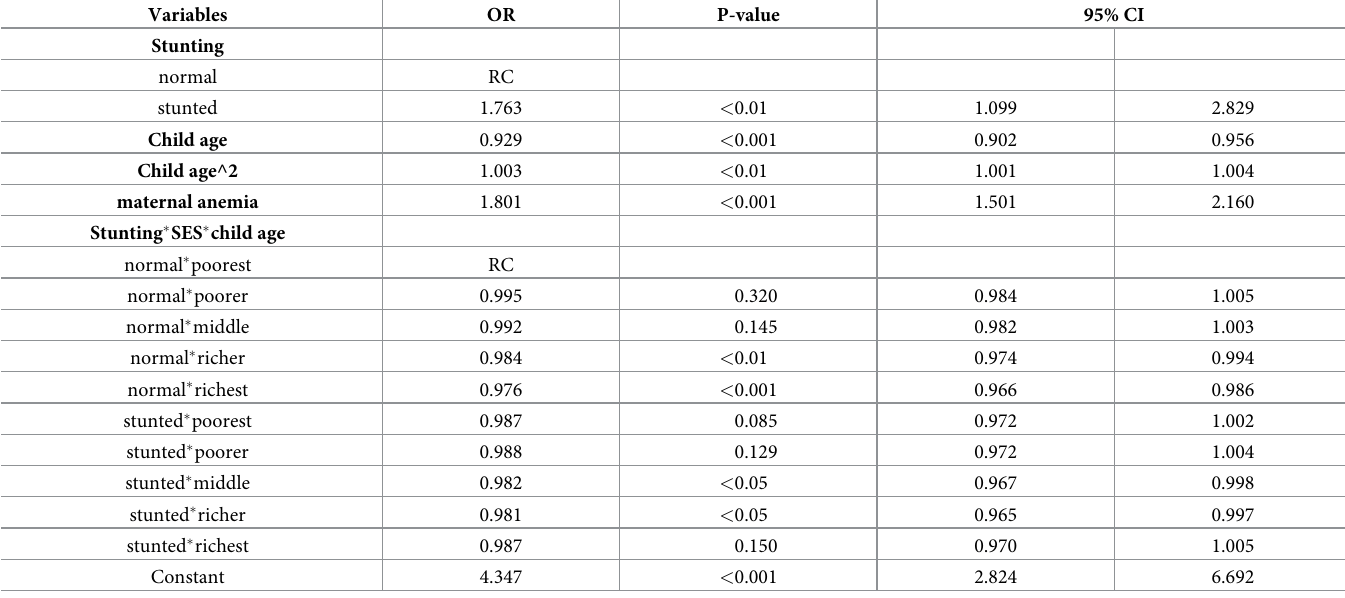
Table 5. Results from multivariable logistic regression analysis of child anemia